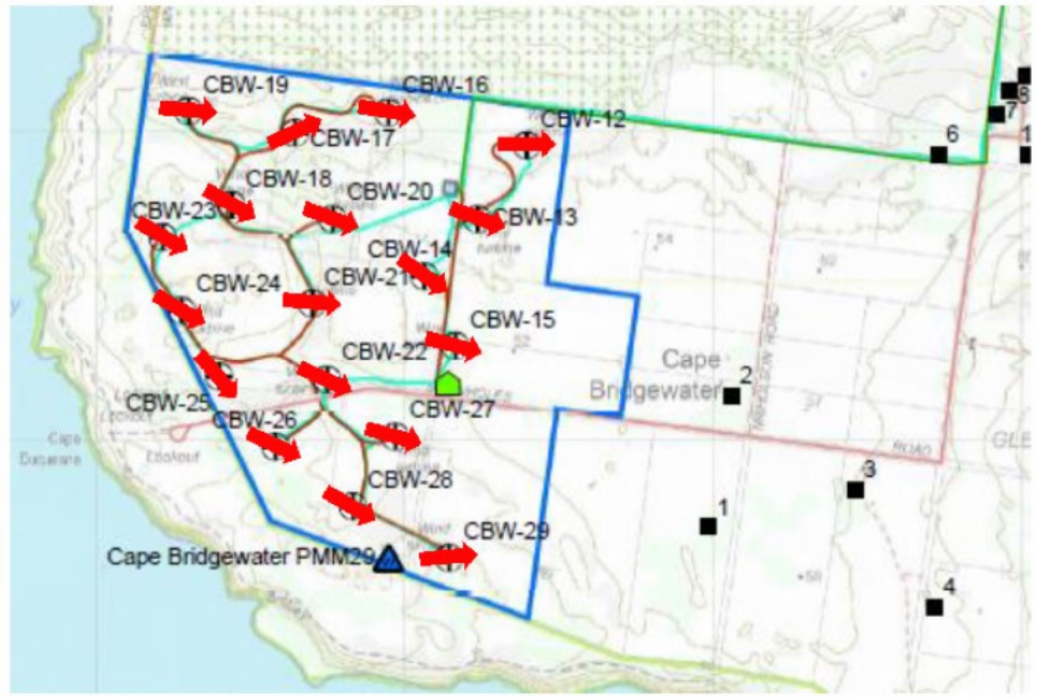
Figure 18. Cape Bridgewater Wind Farm (Southern end), Average wind direction 9.00 a.m.–9.10 a.m. on 10th June